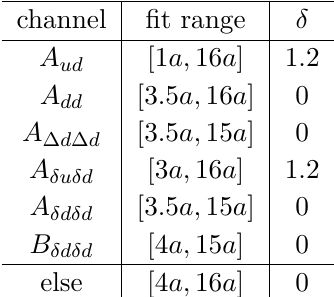
Table 5 . Fit ranges in y used for the fit of each twist-two function for the double exponential (4.2). We also give the fixed parameter δ . In all cases, y